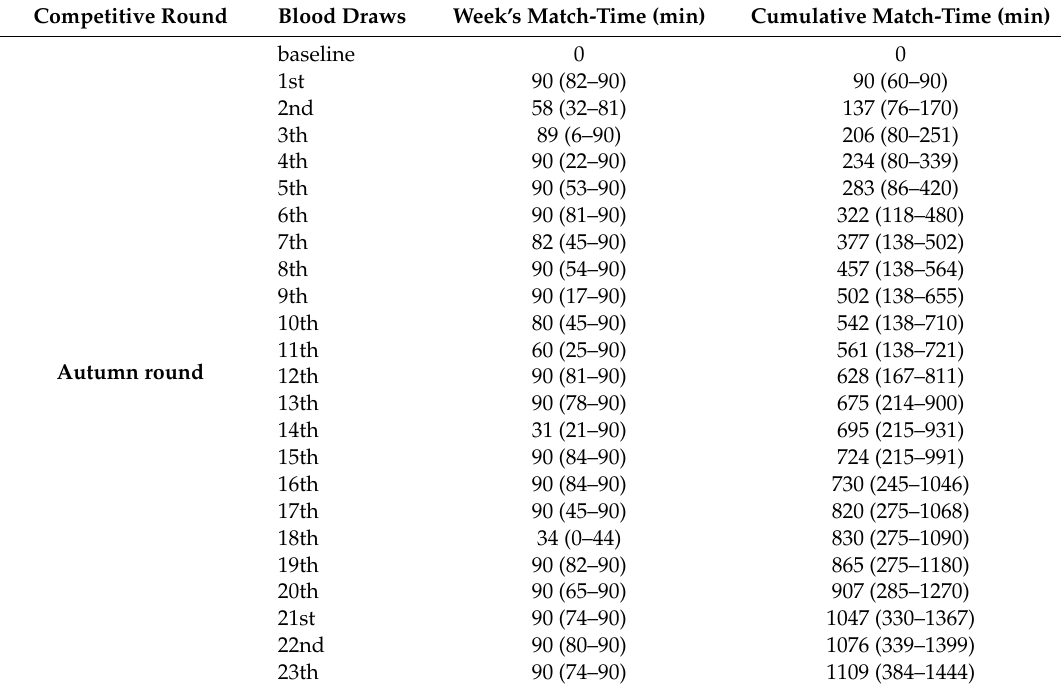
Table 1. A summary of the players’ game